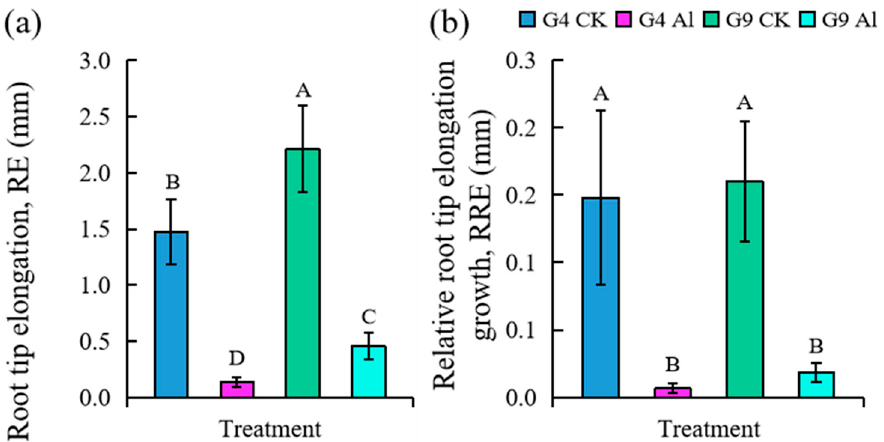
Figure 2. Effects of Al stress on ( a ) root tip elongation (RE) and ( b ) relative root tip elongation (REE) of Eucalyptus clones G4 and G9 after 24 h of Al treatment. Note: data in histogram represent root length after 24 h of Al treatment minus root length at beginning of Al treatment. Bars with different letters indicate significant difference at p < 0.05; three replicated samples used ( n = 3).